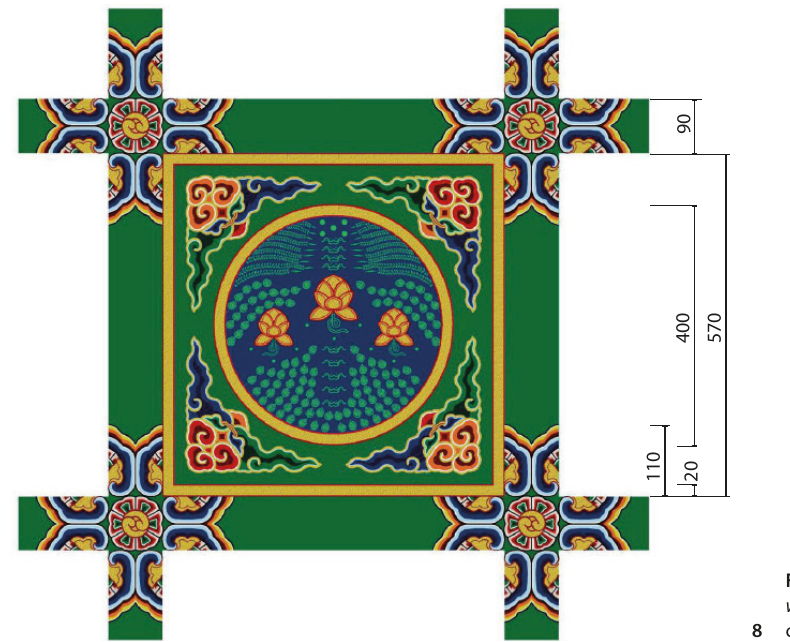
Figure 8 Lotus-and-watergrass pattern on the wuding ceiling of the eastern and western warmth chambers (Source: Hong